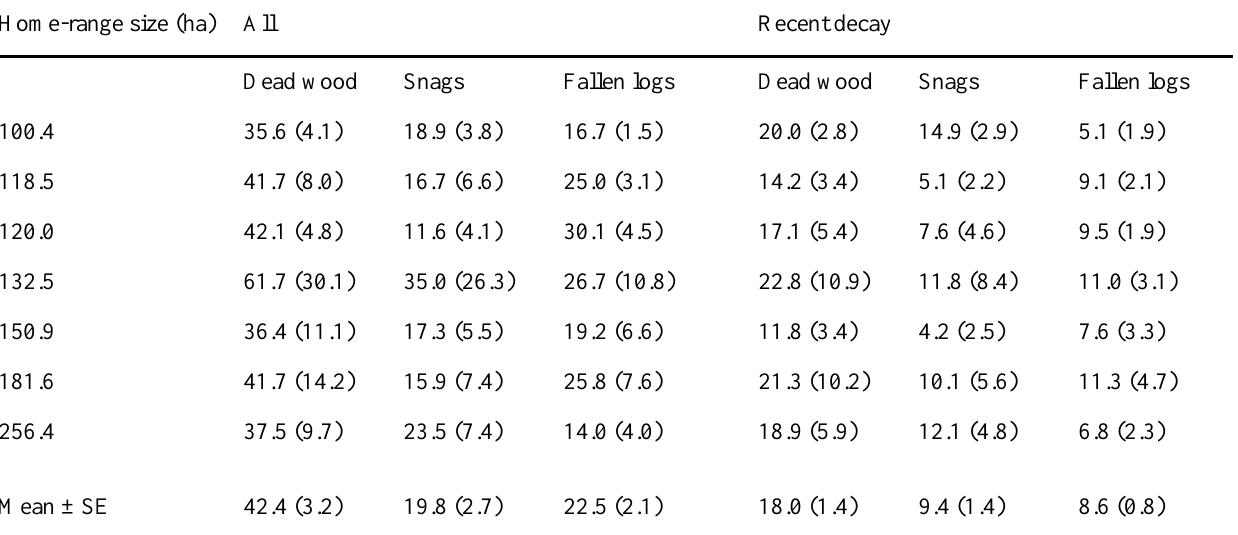
Table 4. Mean (SE) dead wood, snags, and fallen log volumes (m³ • ha -1 ) of total and recently decayed stages (decay classes 1 and 2) in asymptotic Black-backed Woodpecker home ranges. Home-range size (ha) All Recent decay Dead wood Snags Fallen logs Dead wood Snags Fallen logs 100.4 35.6 (4.1) 18.9 (3.8) 16.7 (1.5) 20.0 (2.8) 14.9 (2.9) 5.1 (1.9) 118.5 41.7 (8.0) 16.7 (6.6) 25.0 (3.1) 14.2 (3.4) 5.1 (2.2) 9.1 (2.1) 120.0 42.1 (4.8) 11.6 (4.1) 30.1 (4.5) 17.1 (5.4) 7.6 (4.6) 9.5 (1.9) 132.5 61.7 (30.1) 35.0 (26.3) 26.7 (10.8) 22.8 (10.9) 11.8 (8.4) 11.0 (3.1) 150.9 36.4 (11.1) 17.3 (5.5) 19.2 (6.6) 11.8 (3.4) 4.2 (2.5) 7.6 (3.3) 181.6 41.7 (14.2) 15.9 (7.4) 25.8 (7.6) 21.3 (10.2) 10.1 (5.6) 11.3 (4.7) 256.4 37.5 (9.7) 23.5 (7.4) 14.0 (4.0) 18.9 (5.9) 12.1 (4.8) 6.8 (2.3) Mean ± SE 42.4 (3.2) 19.8 (2.7) 22.5 (2.1) 18.0 (1.4) 9.4 (1.4) 8.6